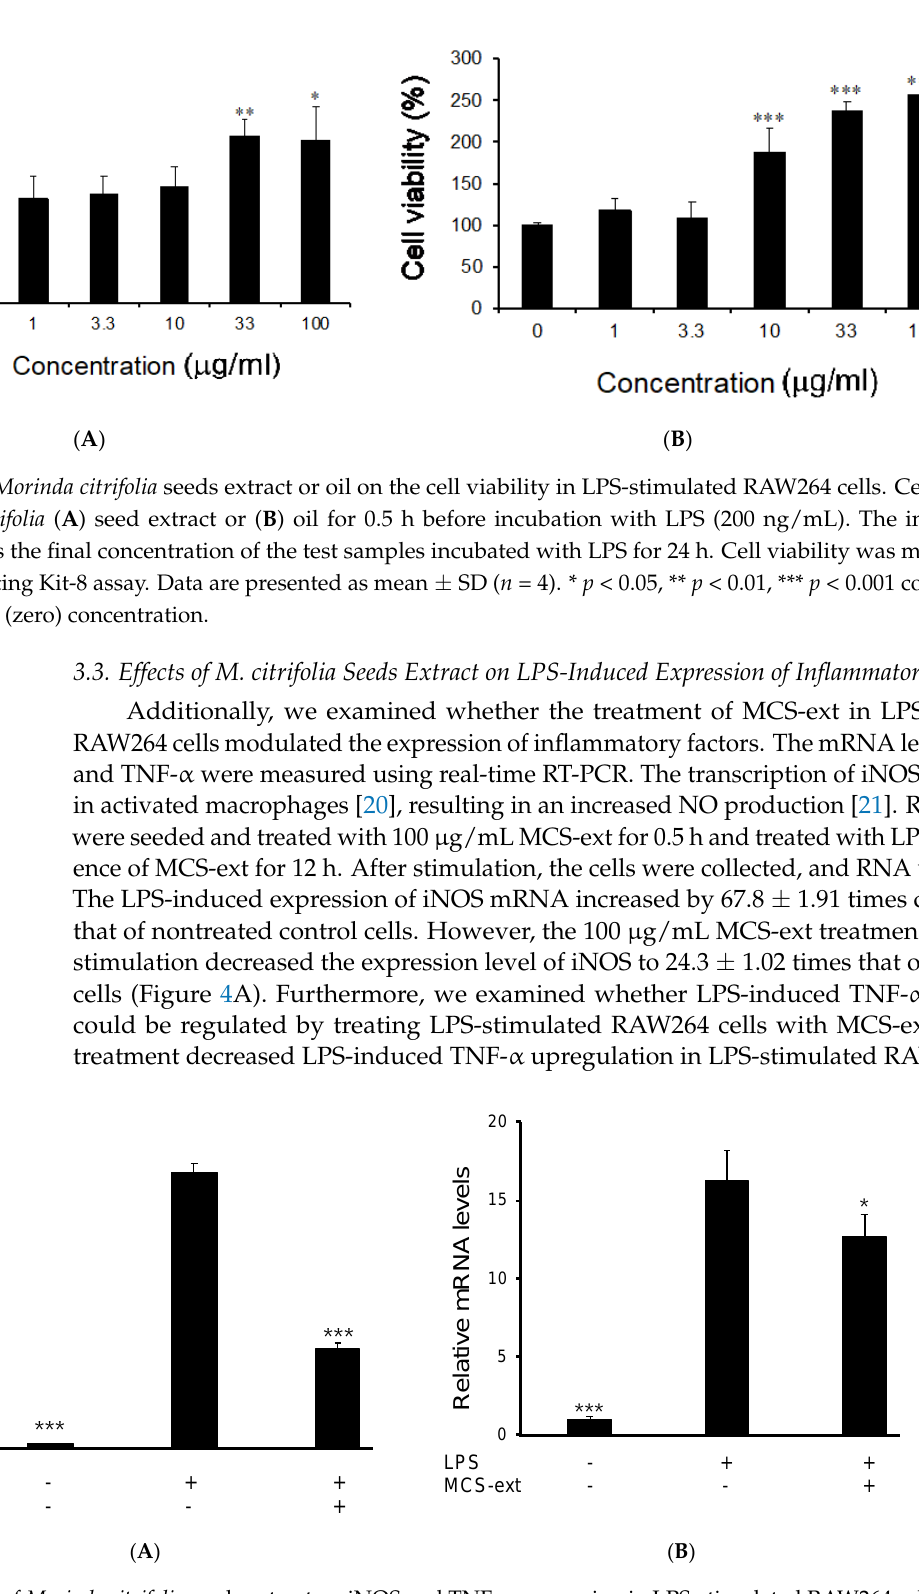
Figure 4. The effects of Morinda citrifolia seeds extract on iNOS and TNF- α expression in LPS-stimulated RAW264 cells. Cells were treated with MCS-ext (100 µ g/mL) for 0.5 h before incubation with LPS (200 ng/mL). After 12 h of LPS stimulation, total RNA was isolated using Isogen II. ( A ) iNOS and ( B ) TNF- α mRNA levels were analyzed using real-time RT-PCR. The relative mRNA levels were determined using the Ct value method and normalized to β -actin expression. Data are presented as mean ± SD ( n = 3). * p < 0.05, *** p < 0.001 compared to the LPS-treated